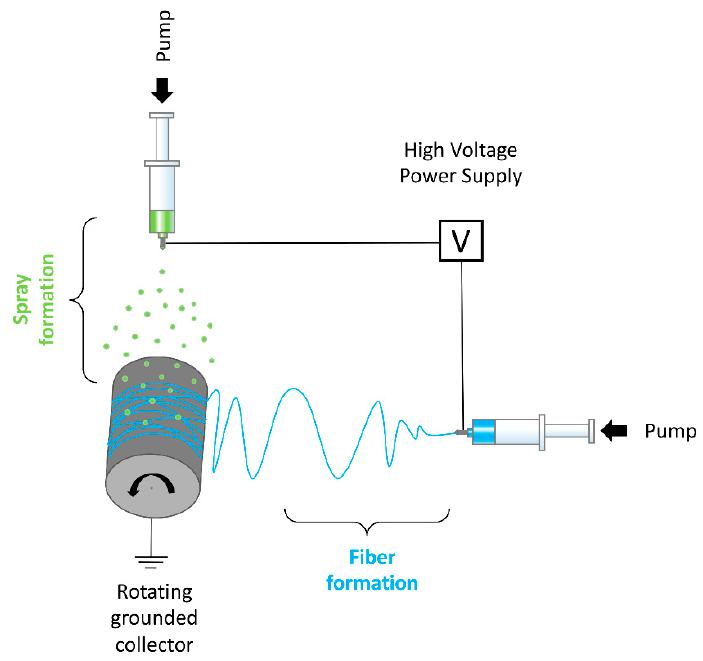
Figure 1. Electrospinning setup combined with electrospraying.